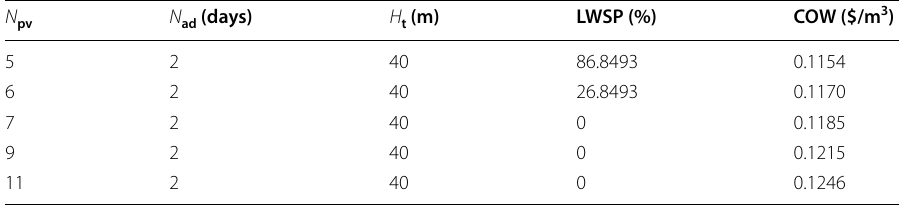
Table 7 Influence the PV modules size on the cost and reliability of the